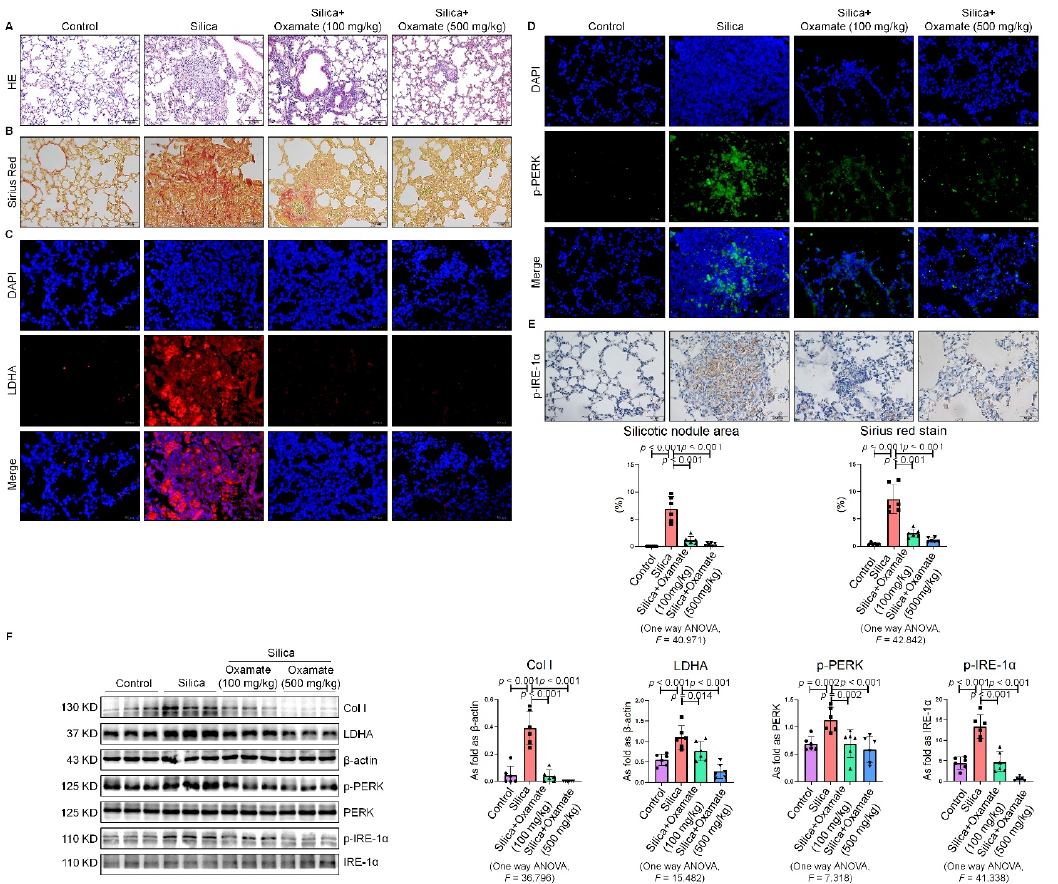
Figure 7. Oxamate reduced glycolysis and ER stress in silicotic mice. ( A ) HE. staining of lung tissue in mice exposed to silica (scale bar = 100 µm). ( B ) Sirius red staining of lung tissue in mice exposed to silica (scale bar = 50 µm). ( C ) Expression of LDHA in mice exposed to silica measured by IF staining (scale bar = 50 µm). ( D ) Expression of p-PERK in silicotic mice measured by IF staining (scale bar) = 50 µm. ( E ) Positive expression of p-IRE-1 α in silicotic mice observed by IHC staining (scale bar = 50 µm). ( F ) Expression levels of collagen type I (Col I), LDHA, p-PERK, and p-IRE-1 α in mice lungs measured by Western blotting. Data are presented as the mean ± SD, n = 6 per group.